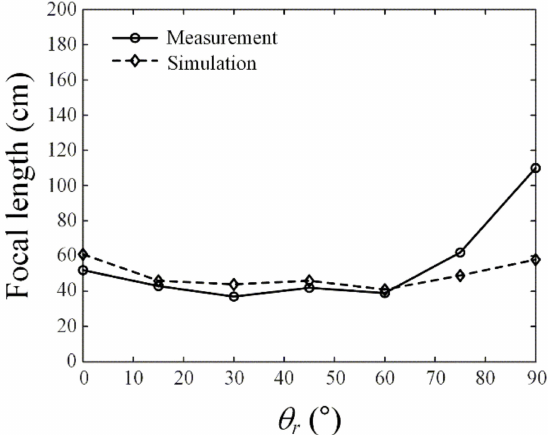
Figure 10. Measured and simulated focal length according to the rotation